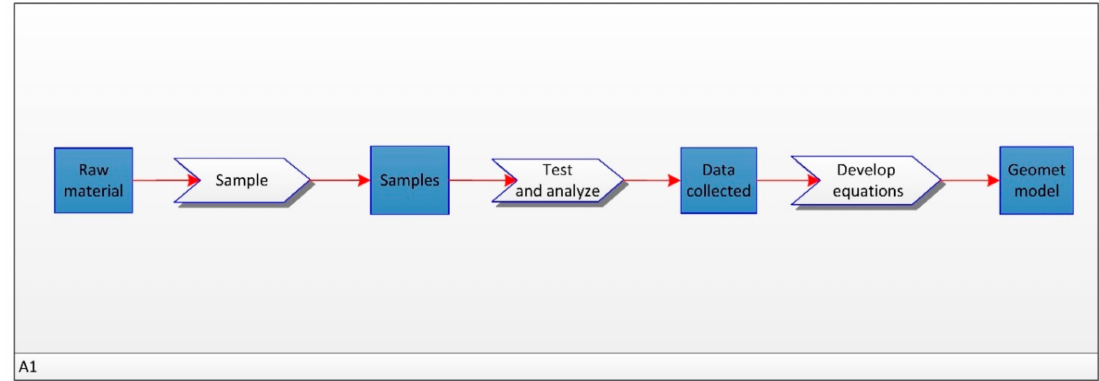
Figure 5. A child diagram of the Build geometallurgical model